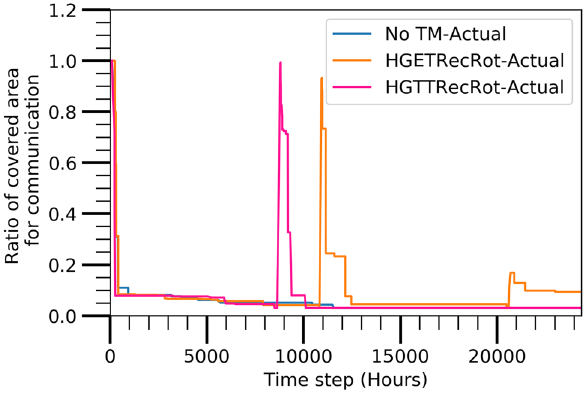
Figure 9. Actual evaluated covered communication area.